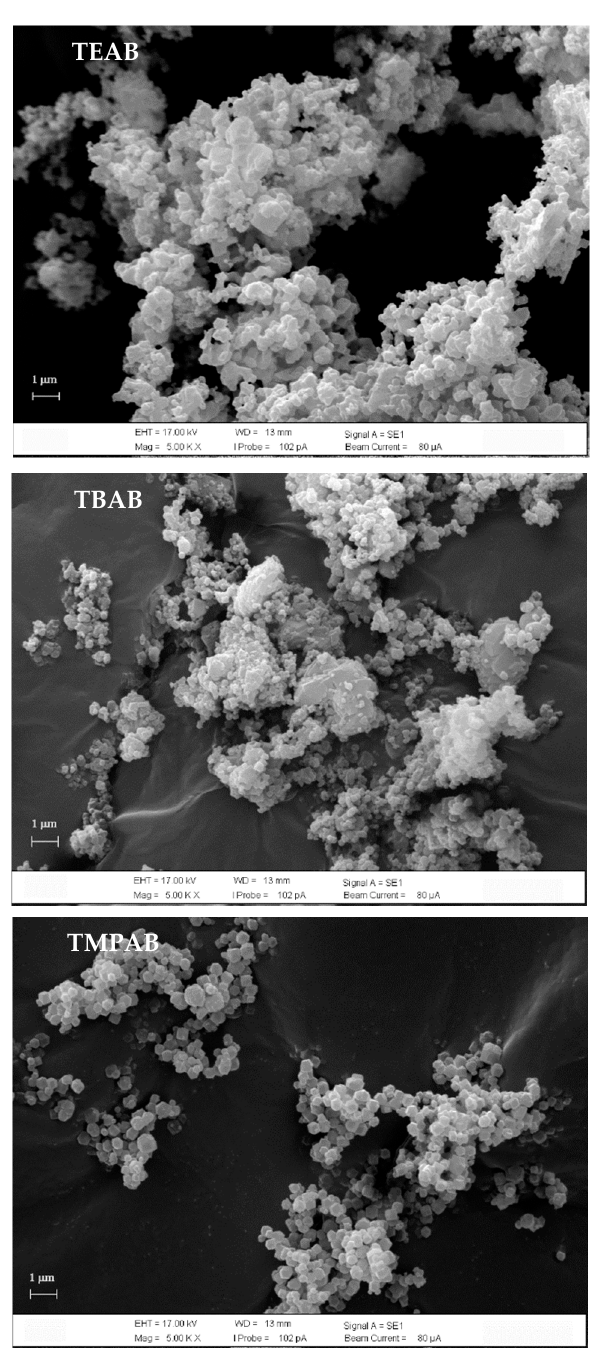
Figure 3. SEM images of ZIF-8 obtained from di ff erent quaternary ammonium